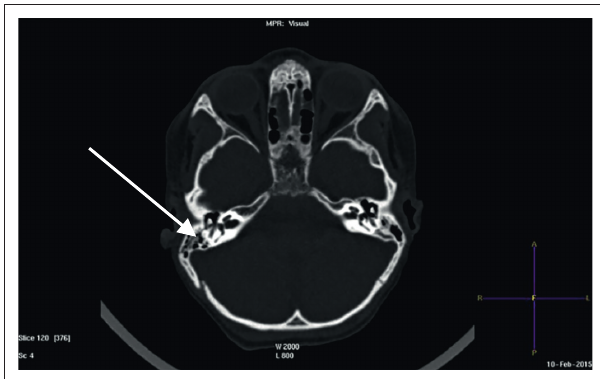
FIGURE 4: A 6 year old boy presented with a closed head injury and right otorrhea, following a fall from a moving vehicle. Axial CT bony algorithm demonstrated partially opacified right mastoid air cells. A subtle linear fracture was seen traversing the right mastoid temporal bone (white arrow).